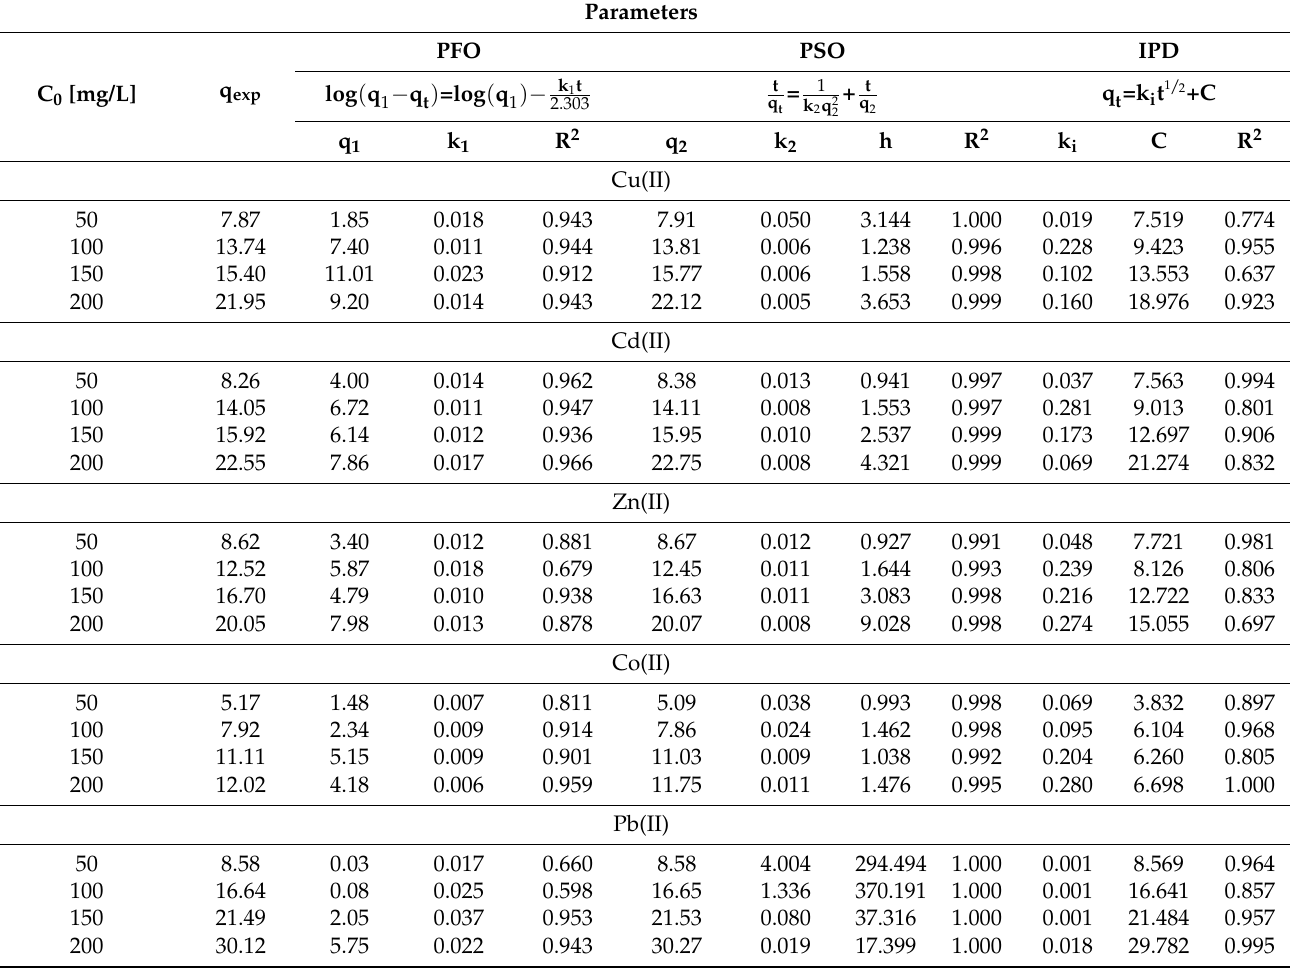
Table 3. Parameters of the various adsorption kinetic models for the Cu(II), Cd(II), Zn(II) Co(II) and Pb(II) sorption on BC-CS